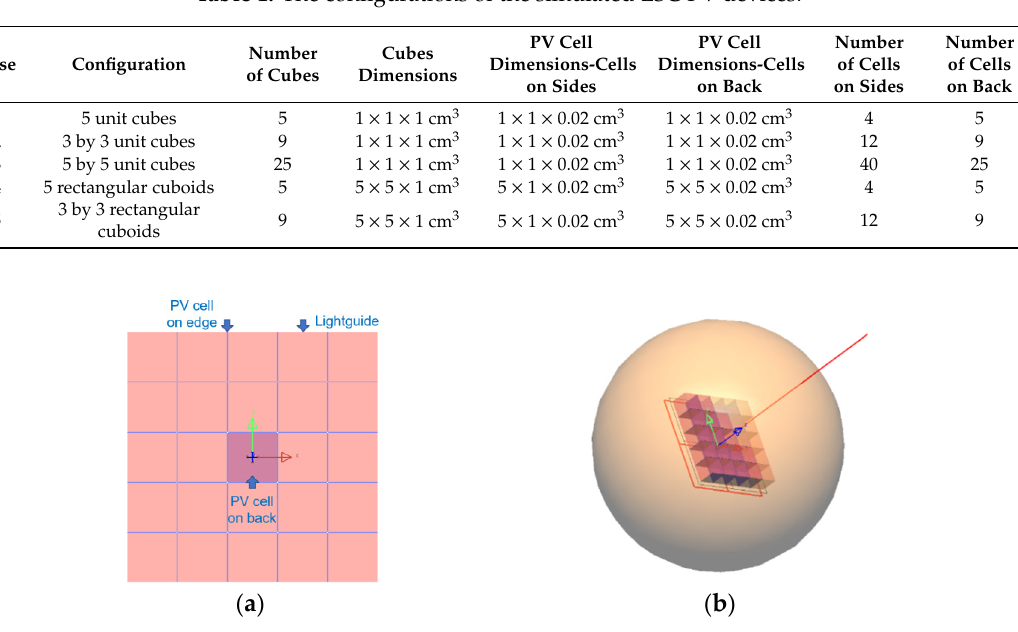
Table 1. The configurations of the simulated LSC PV devices.